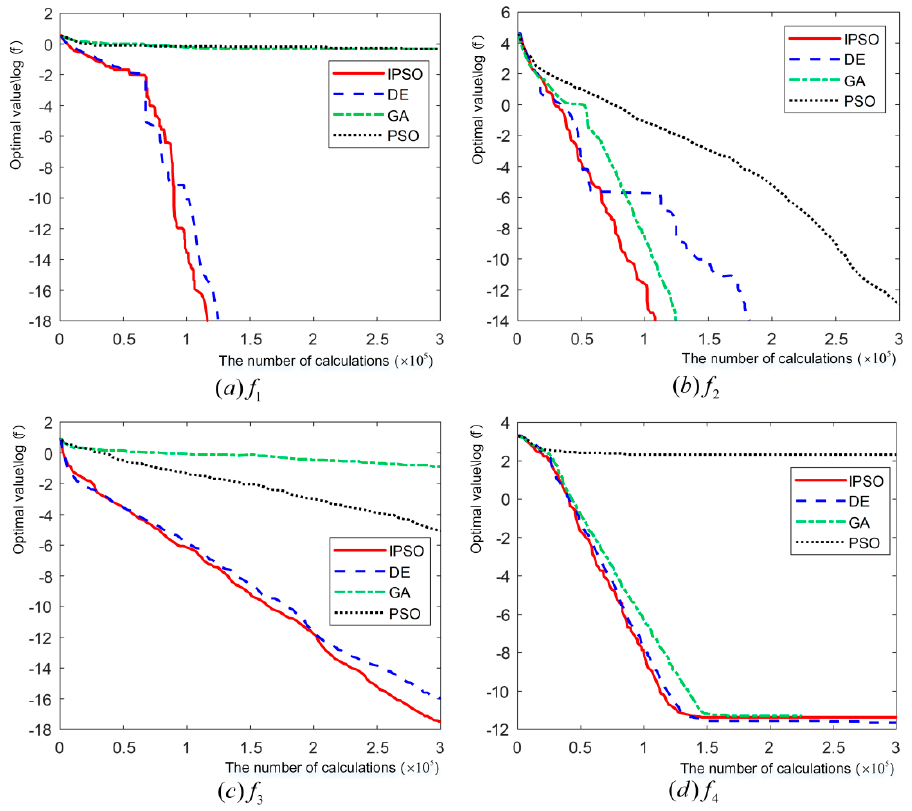
Figure 20. Algorithm comparison graph.